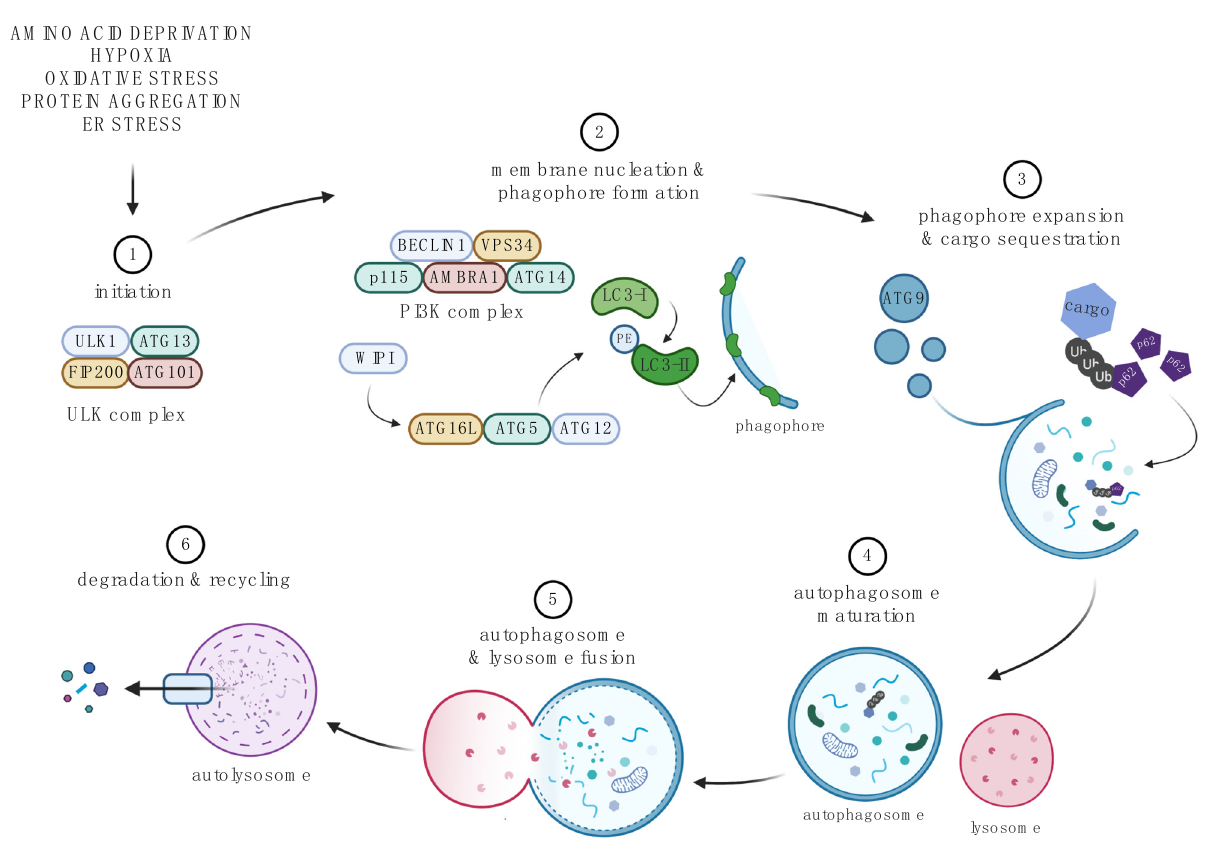
Figure 2. The macroautophagy pathway. 1. Initiation begins with the formation of the ULK complex, which is inhibited by mTORC1, and consists of ULK1, ATG13, RB1-inducible coiled-coil protein 1 (FIP200), and ATG101 [47–49]. 2. The PI3K complex, which comprises of Beclin-1, VPS34, AMBRA1, ATG14, and p115, together with the ULK complex, controls membrane nucleation and phagophore formation. WIPIs are recruited by phosphorylated lipids (PI3P), which in turn results in covalent conjugation of the ATG12-ATG5-ATG16L complex using ubiquitin-conjugation machinery. The ATG12-ATG5-ATG16L enhances the lipidation of LC3-I (Light Chain 3 (LC3) was originally identified as a subunit of microtubule-associated proteins 1A and 1B) to form LC3-II, conjugated to phosphatidylethanolamine (PE), and acts a scaffold to continue phagophore formation [47–49]. 3. ATG9-containing vesicles contribute to phagophore expansion. Cytoplasmic cargo such as aggregated proteins and proteins bound to p62 or LIR sites of LC3 is sequestered into the maturing autophagosome [47–49]. 4. Autophagosome is sealed, and SNARE proteins are recruited to form a mature autophagosome [47–49]. 5. Fusion with the lysosome releases protein-degrading hydrolases into the autophagosome. 6. Complete fusion results in the autolysosome. The inner membrane of the autophagosome and its cargo are degraded, and byproducts are released into the cytoplasm to be recycled by the cell [22,53]. Created with BioRender.com. For recent reviews on molecular mechanisms of autophagy see [22,53].